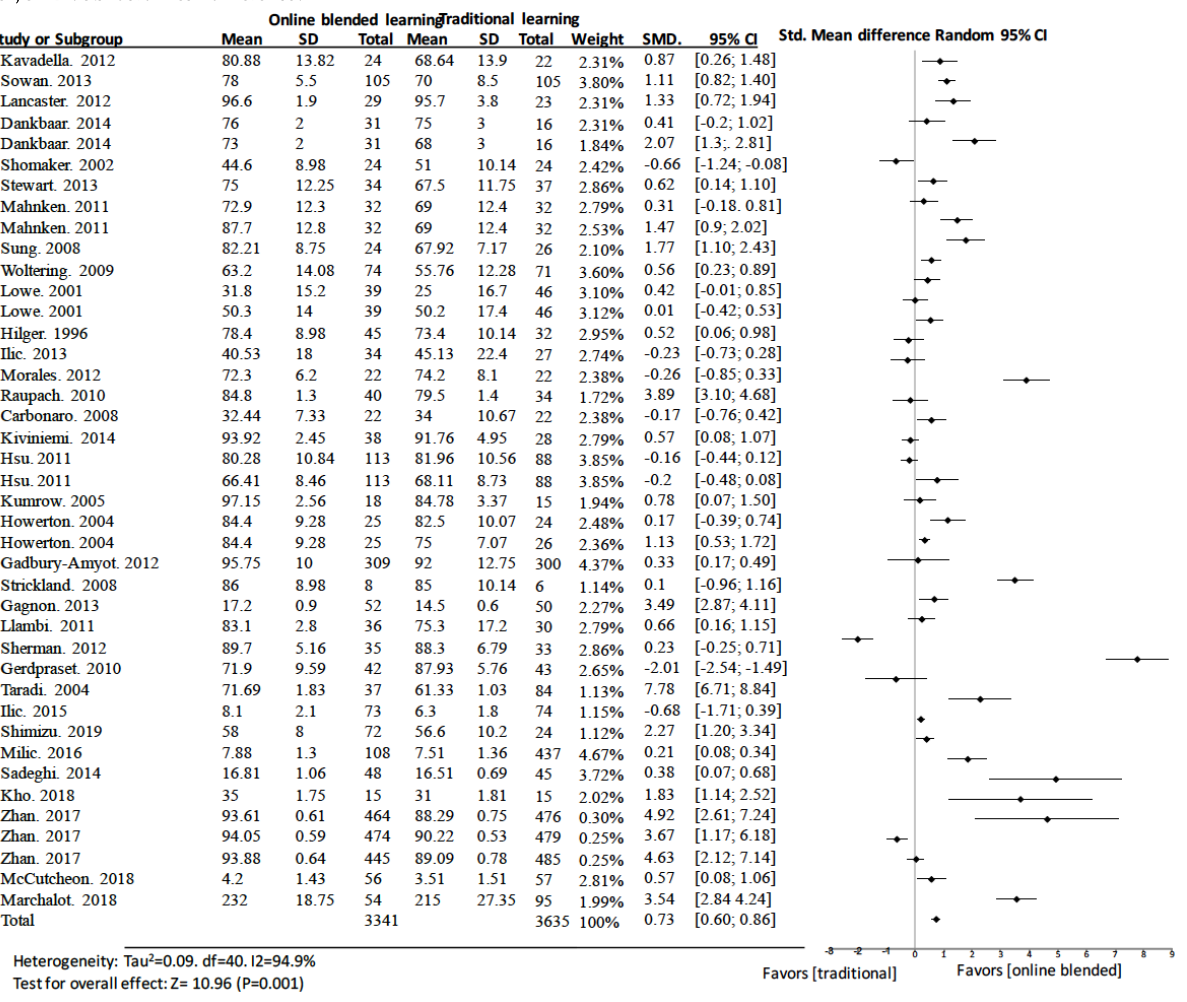
Figure 5. Forest plot of online blended learning to traditional learning comparison for knowledge outcomes. df: degree of freedom; CI: confidence interval; SMD: standard mean difference.